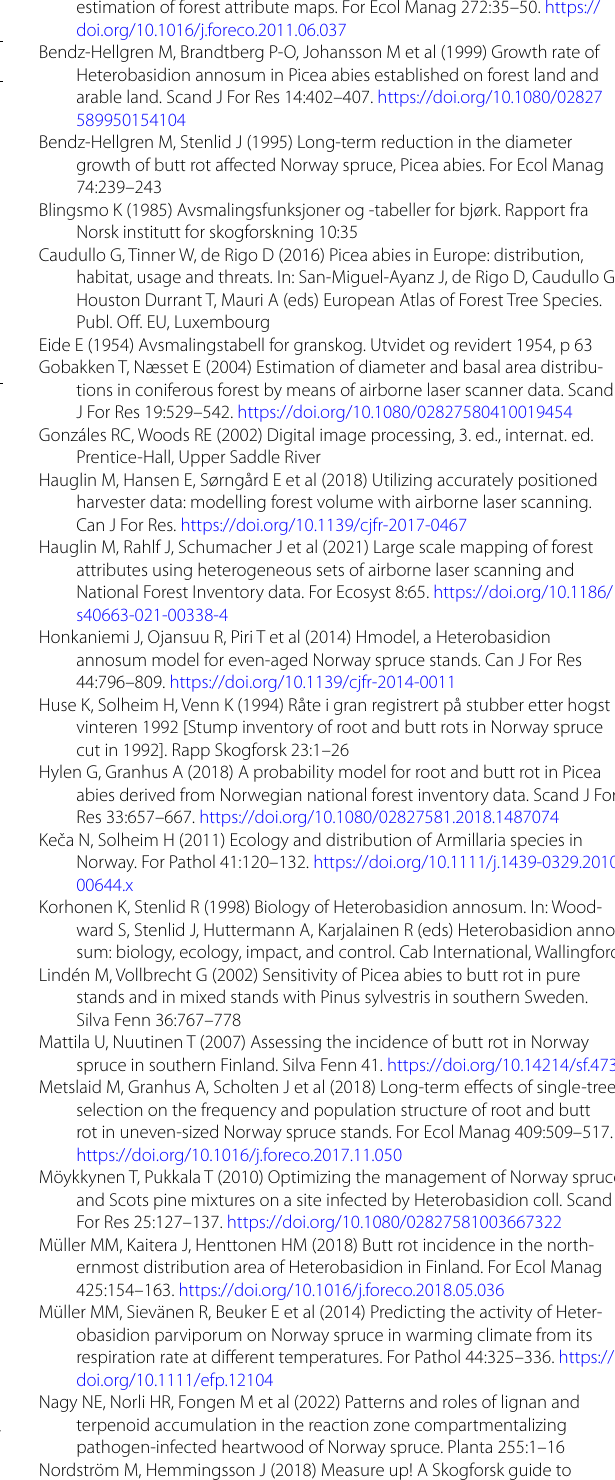
Table 3 Parameter estimates of the model associated with the distribution matching ( DM ). For more information on model DBH formulation and parameters, please refer to Section